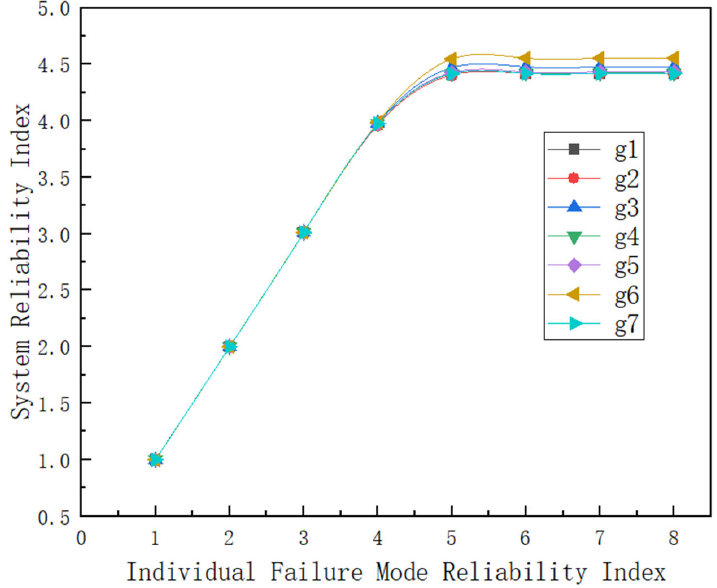
Figure 1. Variation of system reliability indexes with individual failure mode reliability index.